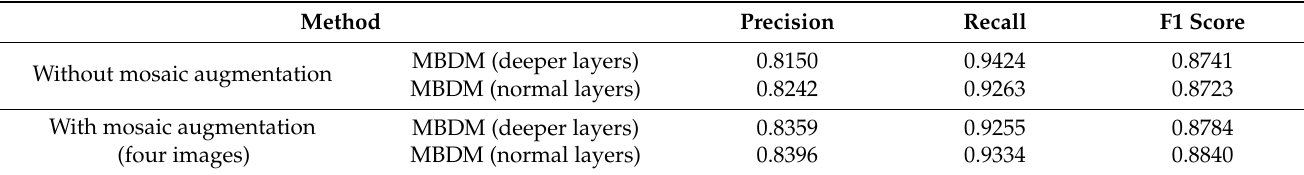
Table 7. Performance comparisons according to MBDM (normal layers) and MBDM (deeper layers) with or without mosaic augmentation.